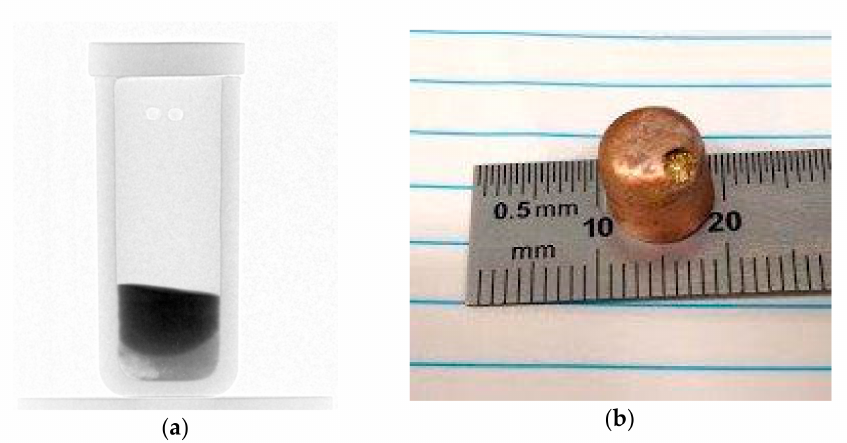
Figure 9. ( a ) Room temperature radiograph of CoCrCu after the melt cycle. The darkest region atop is the Co-Cr-rich phase, while the lighter region to the bottom right was the formation of a void. The lighter gray region toward the bottom right is the Cu-rich phase. ( b ) Photograph of the sample after removal from the crucible, displaying the void that formed during solidification.